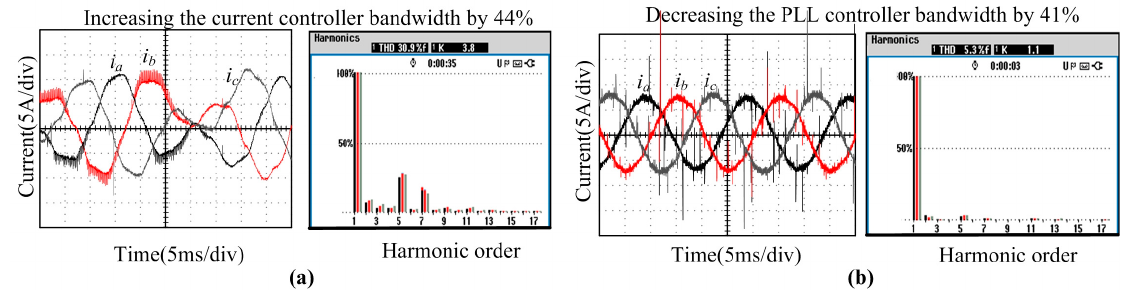
Figure 19. Grid-connected currents comparison under different current reference frame with varied grid impedance. ( a ) Grid-connected currents under dq -domain control with L g = 2 mH; ( b ) Grid-connected currents under αβ -domain control with L g = 2 mH; ( c ) Grid-connected currents under dq -domain control with L g = 4 mH; ( d ) Grid-connected currents under αβ -domain control with L g = 4 mH; ( e ) Grid-connected currents under αβ -domain control with L g = 6 mH.